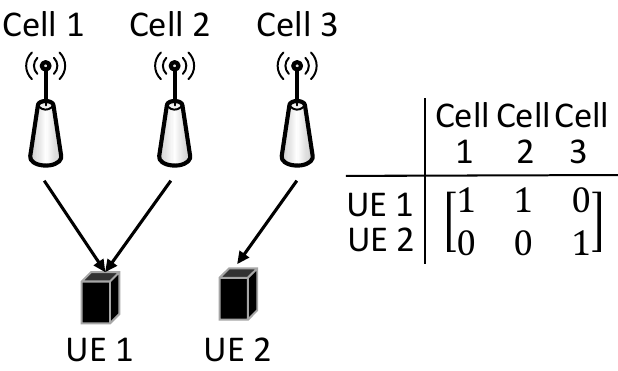
Figure 1. Example of chromosome representation for JT